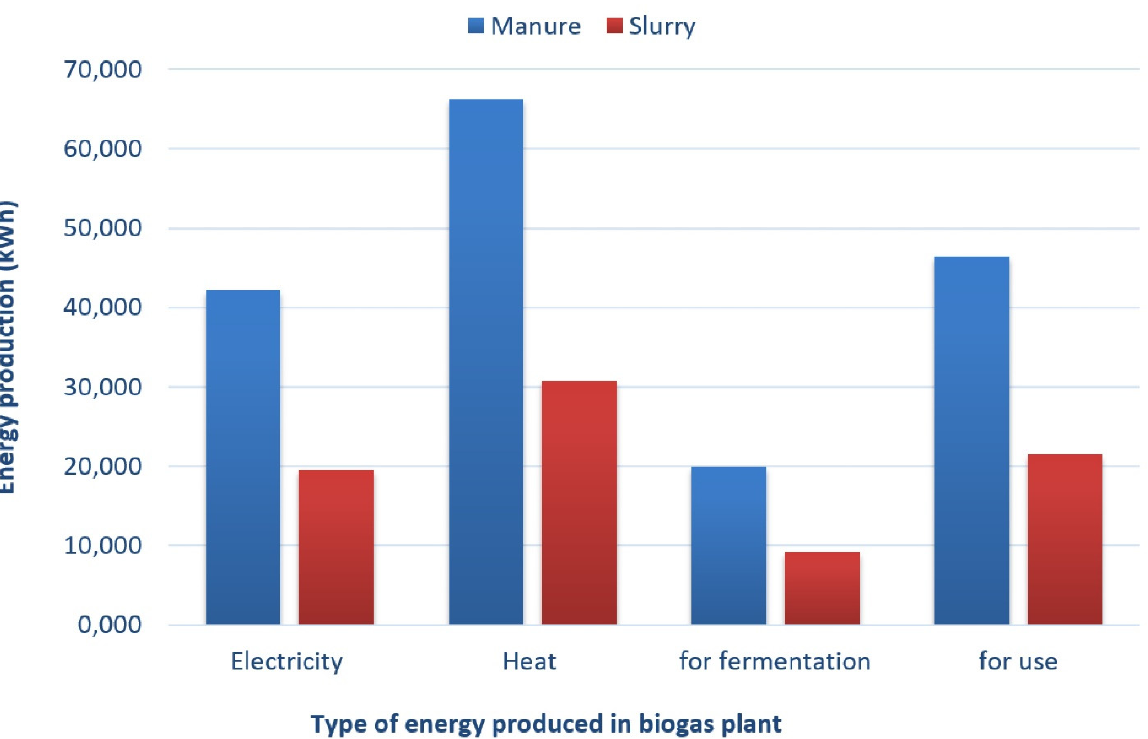
Figure 5. Heat and electric power production from 20 cows on farmland. Own study based on Source: